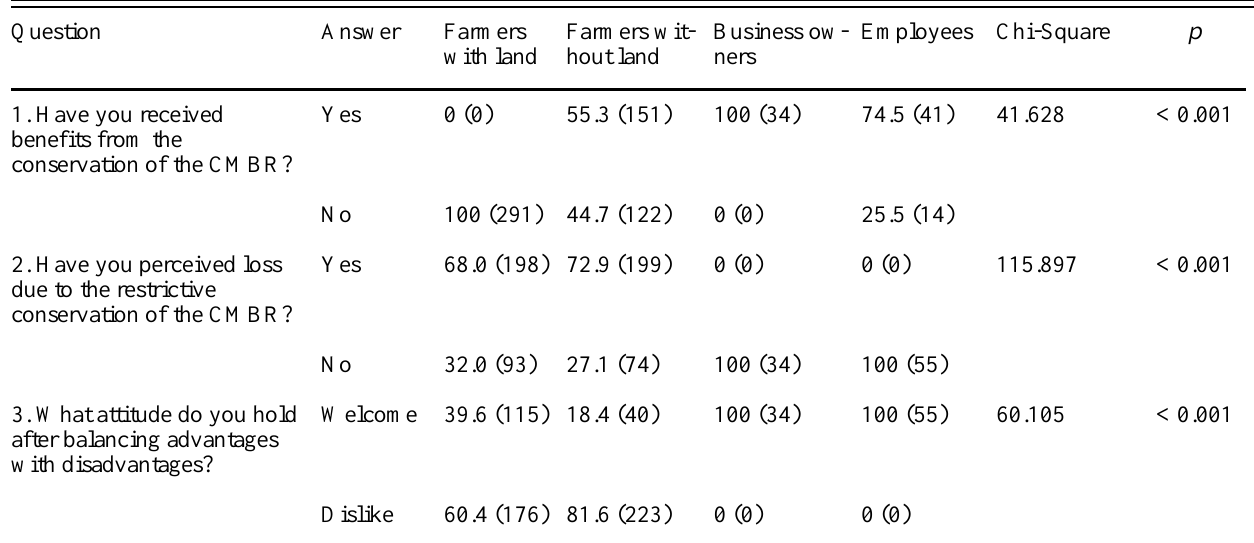
Table 3. Attitudes of respondents toward the Changbai Mountain Biosphere Reserve